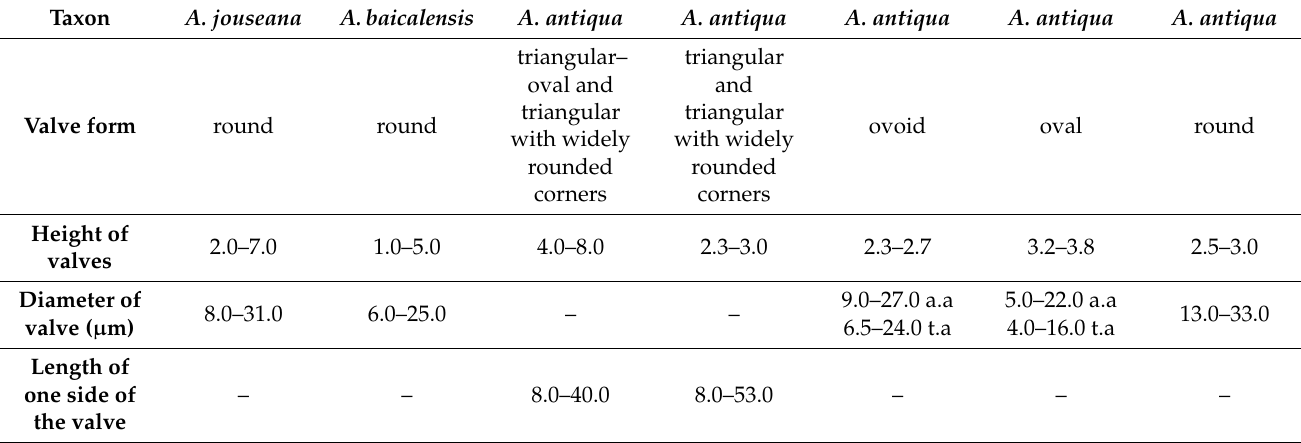
Table 1. Morphological characters of relative Alveolophora